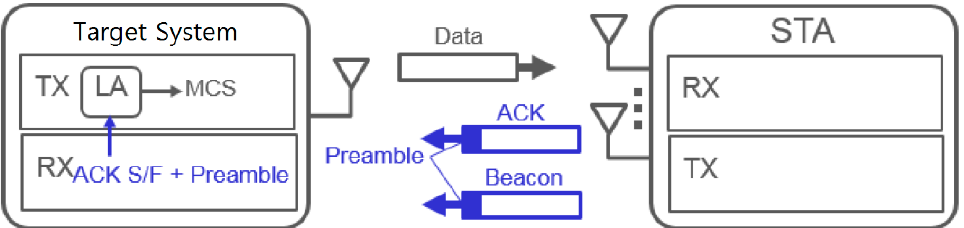
Figure 3. Link adaptation in case of no modulation and coding scheme (MCS) feedback from the receiver (RX) antenna.